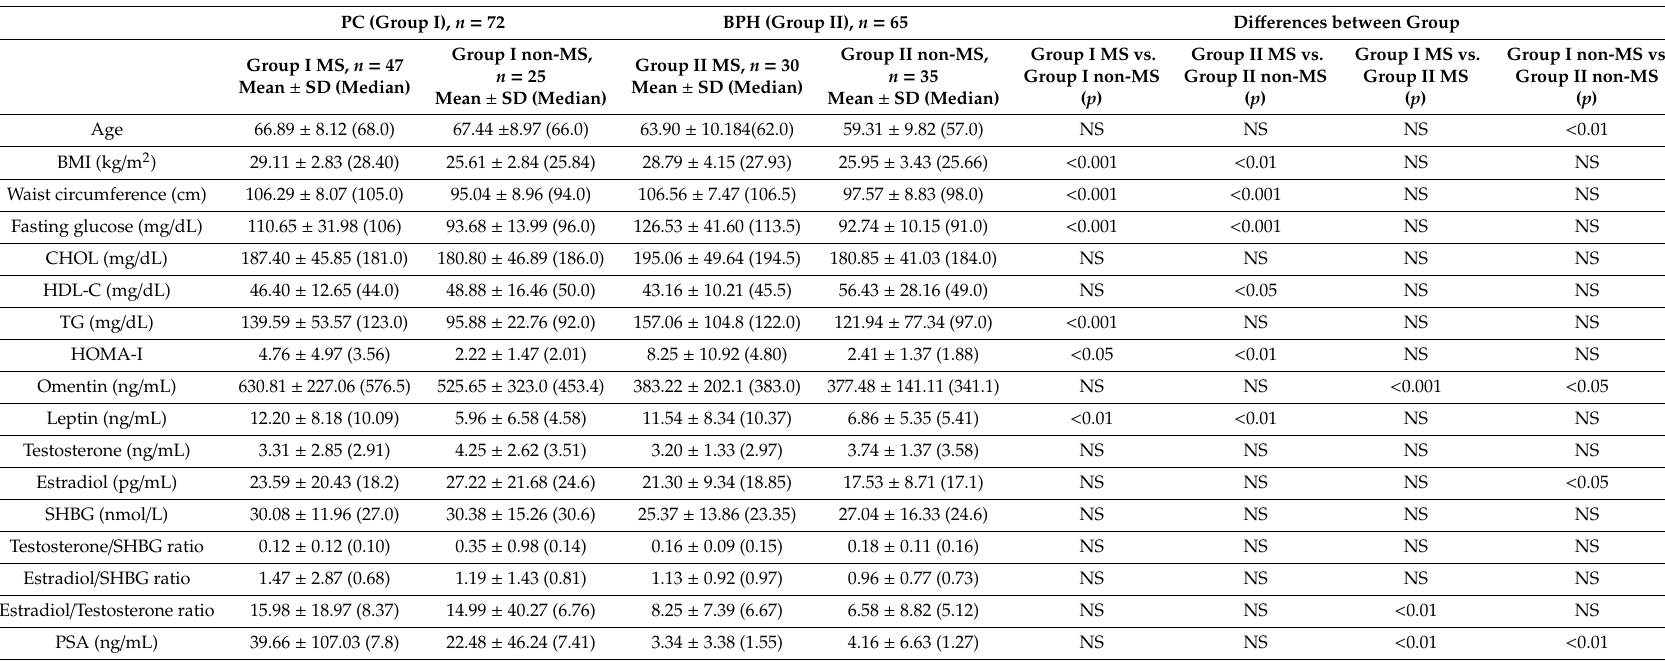
Table 2. The clinical, hormonal, and metabolic characteristics in PC and BPH men stratified by the presence / absence of metabolic syndrome